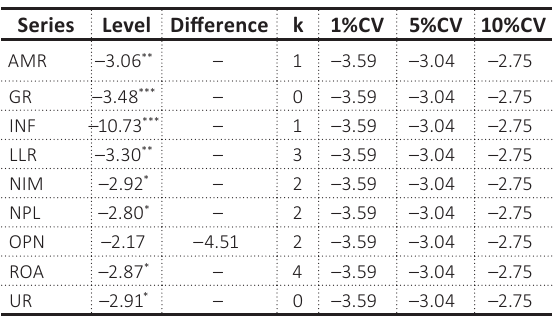
Table 3. Modified Dickey-Fuller unit root